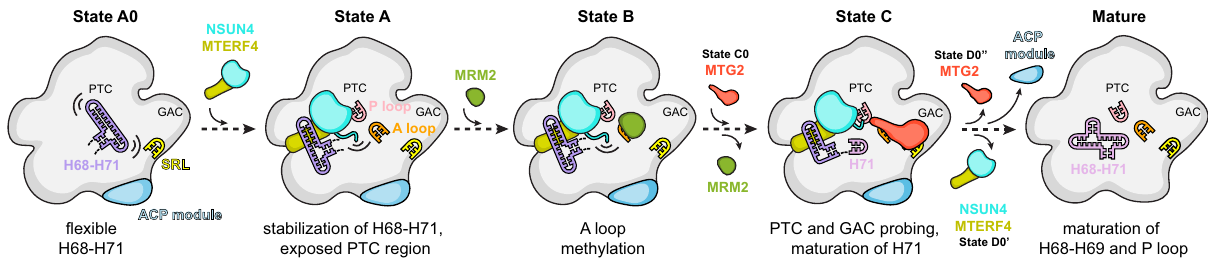
Fig. 4 Model for stepwise maturation of the human mitoribosomal large subunit aided by assembly factors. Eight classes, corresponding to distinct assembly states in this study, allow us to propose the order of events in the late stages of the human mitoribosomal large subunit assembly.